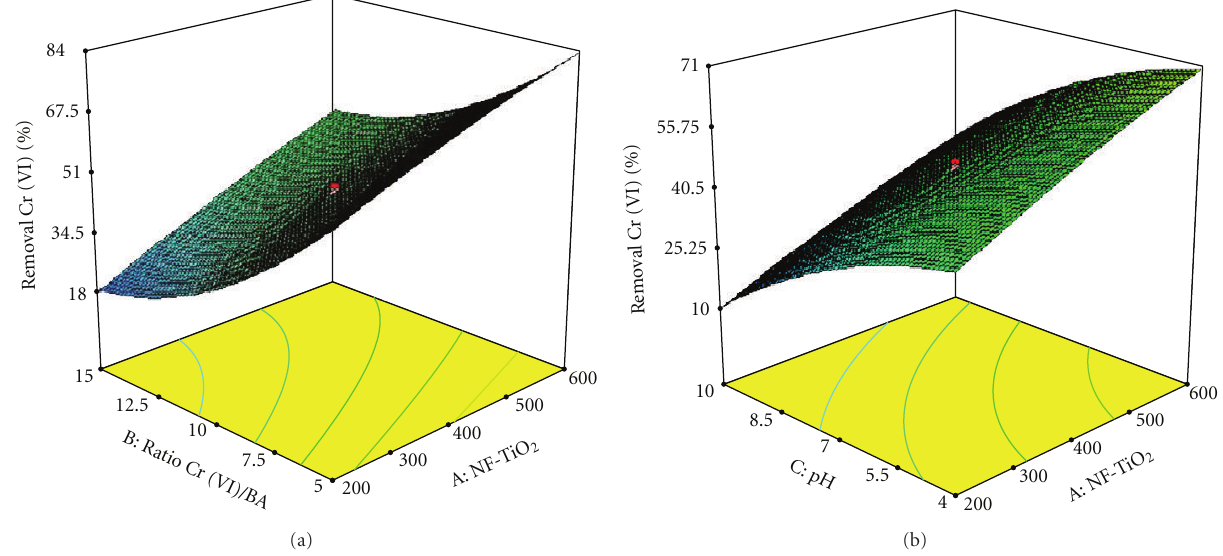
Figure 5: 3D response surface plots for % Cr(VI) removal; (a) as a function of N-F-TiO 2 concentration and Cr (VI)/BA ratio; (b) as a function of pH and N-F-TiO 2 concentration.